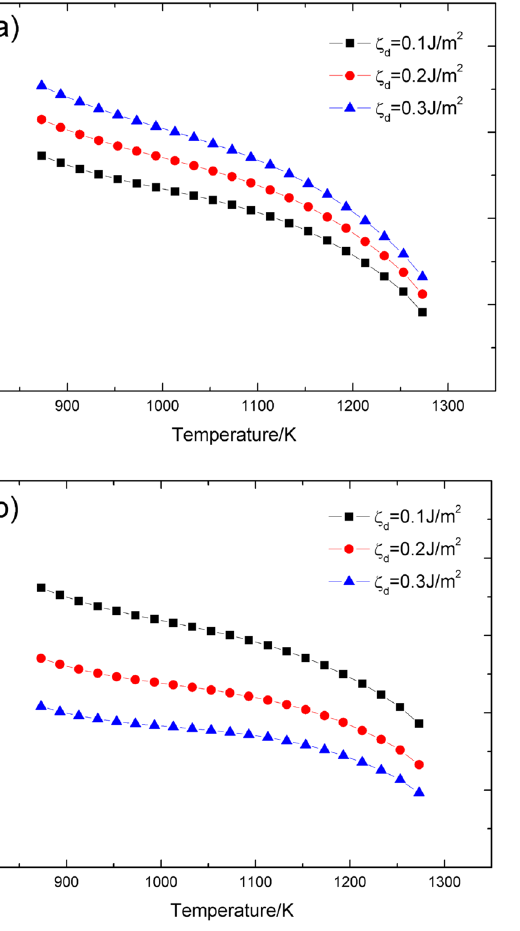
Figure 5: E ff ect of the matrix fracture energy on ( a ) the PLS versus temperature curves and ( b ) the fi ber/matrix interface debonding length versus temperature curves of SiC/SiC